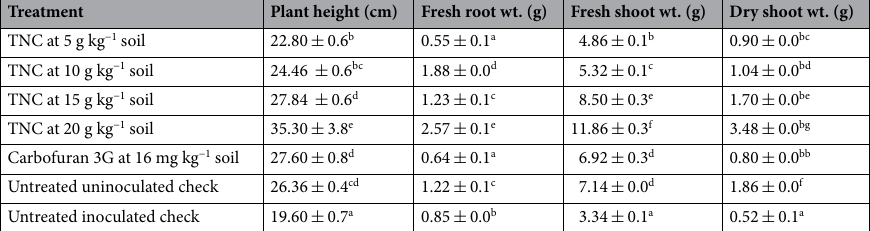
Table 2. Efficacy of T. asperellum FbMi6 enriched neem cake on plant growth parameters of okra infected with M. incognita . Data are mean of five replicates. INP- 2000J 2 /kg. Values with the different letter are significant according to DMRT (p < 0.05). Data are presented as means ± SD. TNC T. asperellum FbMi6 enriched neem cake.